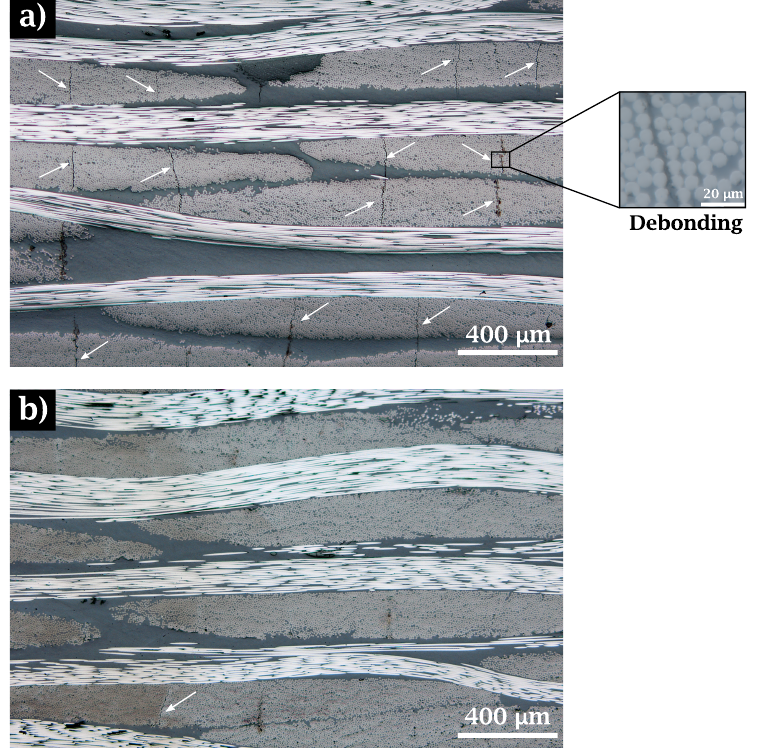
Figure 12. Cross section of laminates for ( a ) Untreated ( Lam 0 ) and ( b ) treated ( Lam I ) composites after consolidation. White arrows show initial debonding.